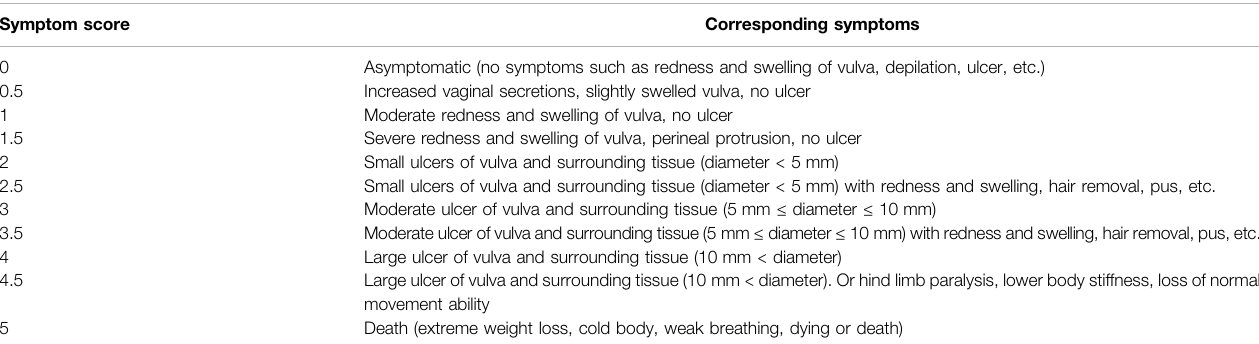
TABLE 2 | Improved symptom score of mice with genital HSV-2 infection. Symptom score Corresponding